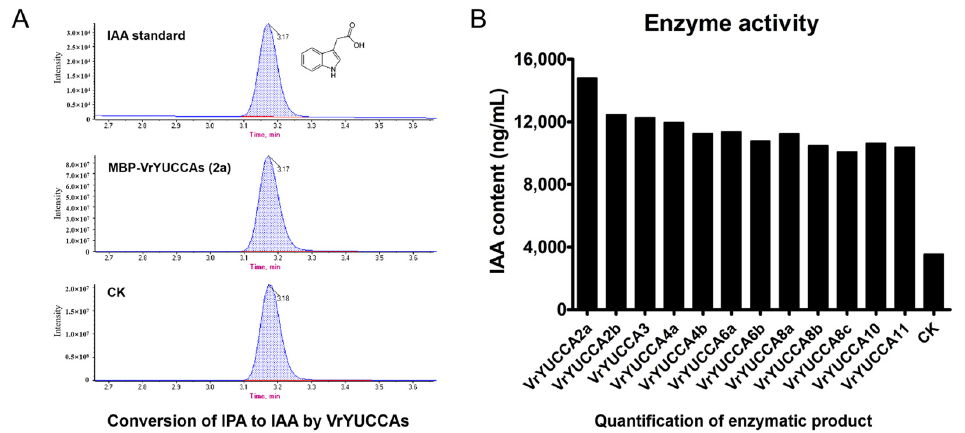
Figure 4. Enzymatic assay of VrYUCCAs with the substrate IPA analyzed by ESI-HPLC-MS/MS. ( A ) The HPLC profile for IAA standard and the enzymatic products. The profile of VrYUCCA2a reaction was selected as a representative here, and the results of other VrYUCCAs are shown in Figure S2. CK: the enzyme reaction mixture containing a boiled protein. The relatively lower HPLC profile in CK was due to spontaneous conversion of IPA to IAA at room temperature. ( B ) The statistical results of the IAA content in enzymatic reaction mixture of VrYUCCAs.